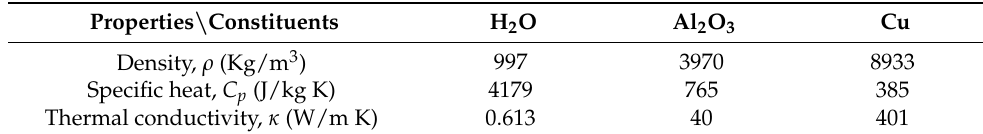
Table 1. Experimental values of various thermophysical properties for base fluid and nanoparti- cles